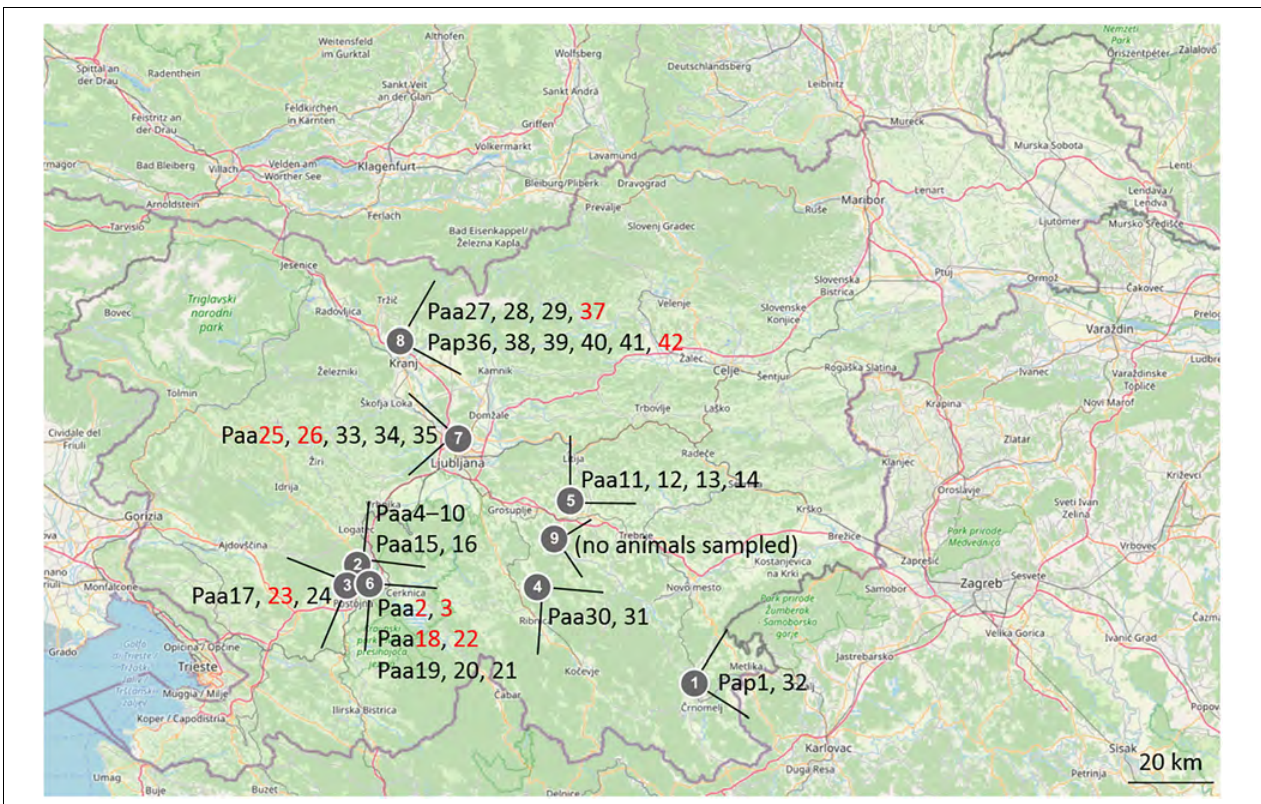
FIGURE 1 | Map of Slovenia with marked sampling locations and sampled olm specimens. 1-Jelševnik, 2-Planinska jama, 3-Èrna jama, 4-Kompoljska jama, 5-Vir pri Stièni, 6-Vivarium 1, 7-Vivarium 2, 8-Vivarium 3, 9-Krška jama. The labels of animals (Paa, Poteus anguinus anguinus ; Pap, Proteus anguinus parkelj ) are written next to locations, in black for asymptomatic, and in red for symptomatic